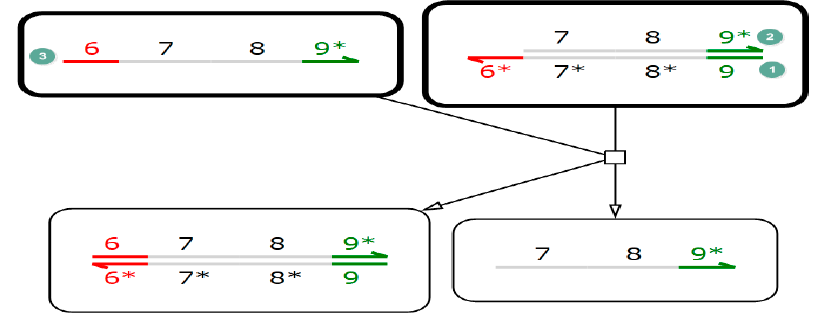
Figure 1. DNA strand displacement.